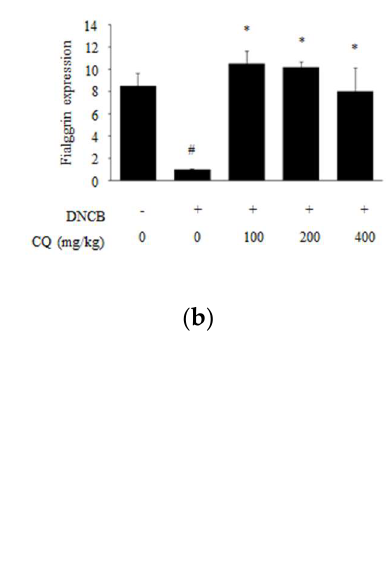
( d ) Figure 5. Histological analysis of epidermal thickness and mast cell infiltration on DNCB-induced